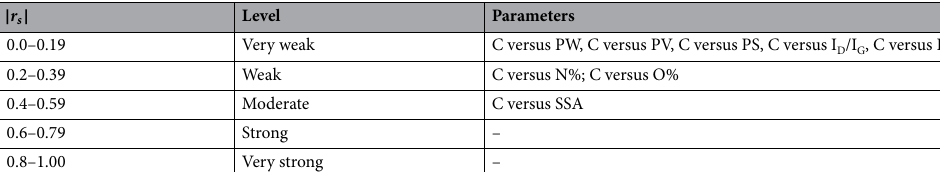
Table 1. Spearman’s rank correlation coefficient between the specific capacitance and different features of carbon supercapacitors in the considered